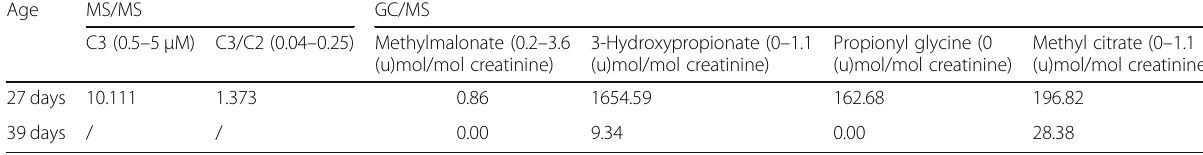
C3: propionyl carnitine, C2: acetyl carnitine, “ / ” :